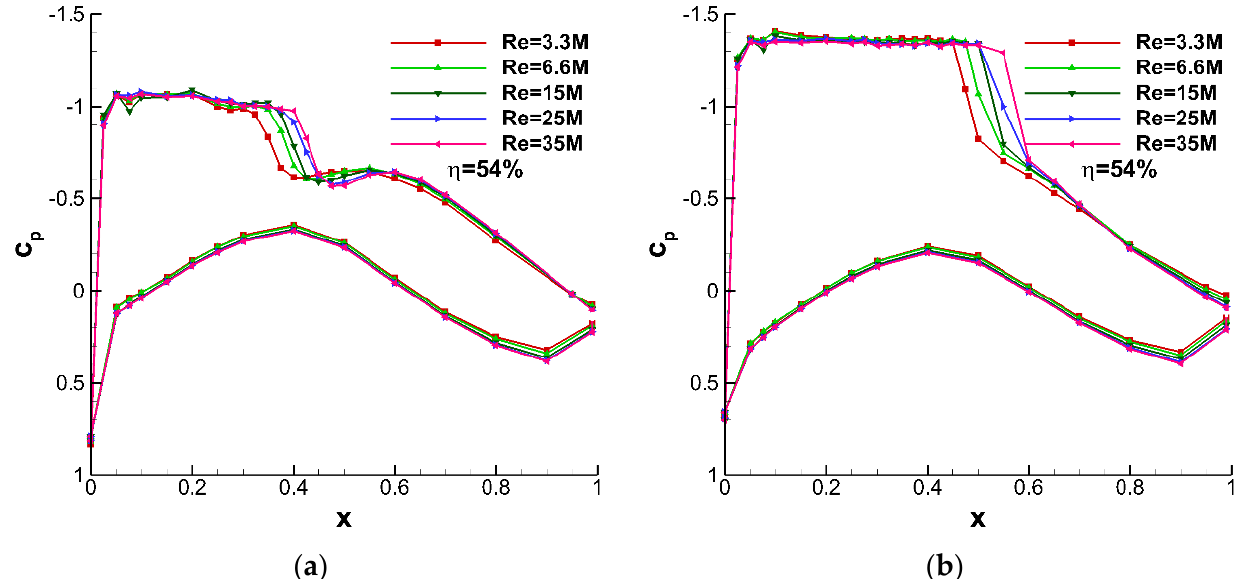
Figure 12. Pressure distributions at different angles of attack and Reynolds numbers (M = 0.76, η = 54%): ( a ) α = 2°; ( b ) α = 4°.